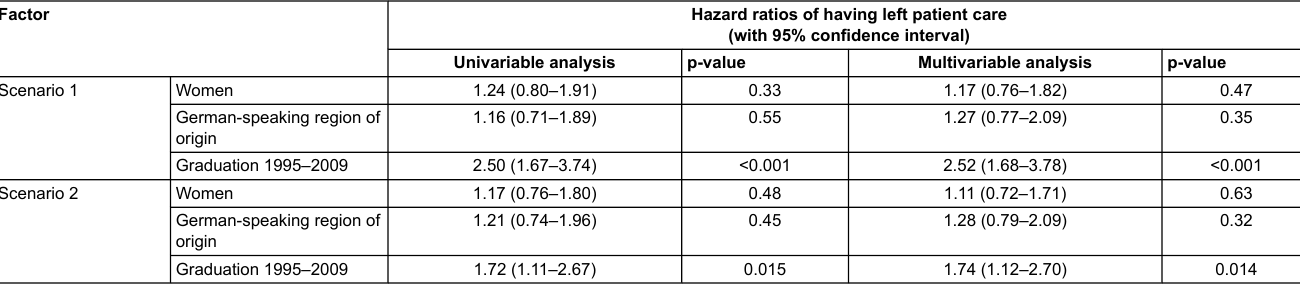
Table 2: Hazard ratios of leaving patient care for the association with gender (women versus men), region (German speaking part of Switzerland versus French and Italian speaking part of Switzerland) and year of graduation (1995–2009 versus 19801994) for scenarios 1 and 2.